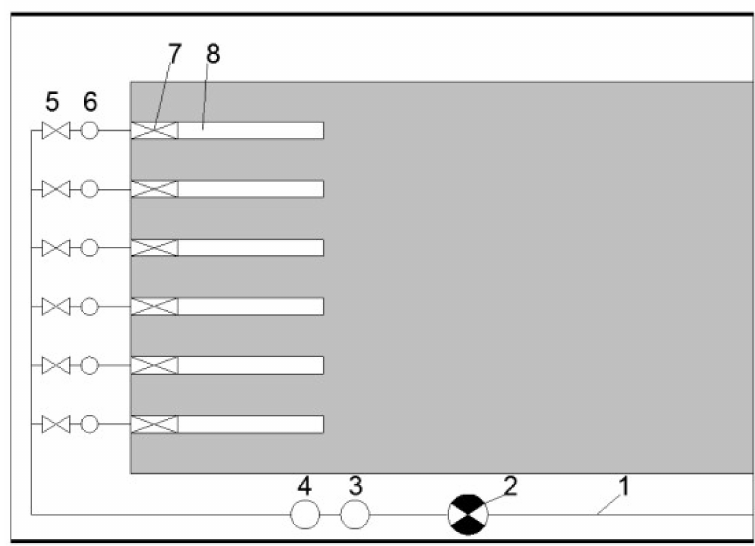
Figure 5. Schematic diagram of the water injection system: 1—water conduct pipe; 2—pressure pump; 3—flowmeter; 4—pressure gauge; 5—Valve; 6—pressure gauge; 7—plugs; 8—borehole.